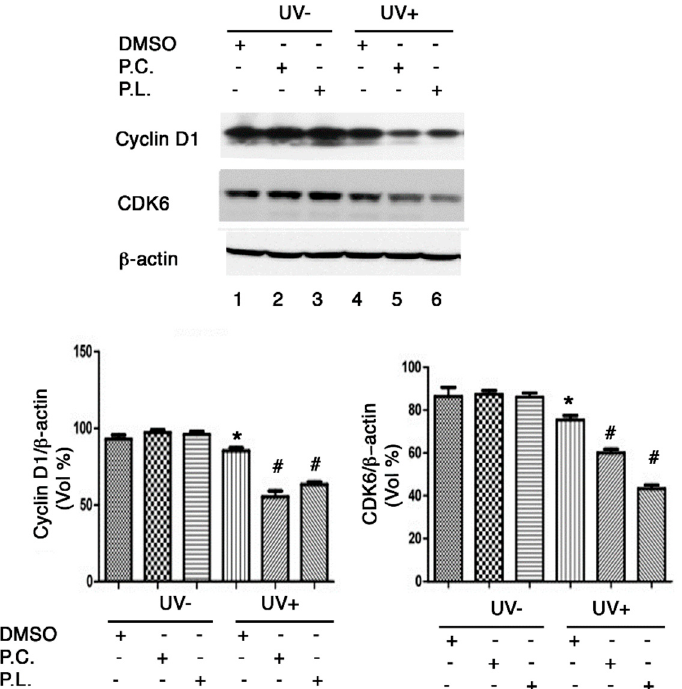
Figure 6. Western blot analysis of G1/S cell cycle regulatory protein expressions in HaCaT cells treated with Perilla leaf or callus extracts. Effects of Perilla leaf and callus extracts on the UVB-induced protein levels of Cyclin D1 and CDK6 in HaCaT cells. Cells were treated with Perilla leaf, callus extracts (0.1 µ g/mL), or DMSO (negative control) overnight, washed with PBS, irradiated with UVB (30 mJ/cm 2 ), and harvested 3 h later. Pellets were subjected to Western blotting using β -actin as a loading control. (Top panel) Representative Western blot for cyclin D1 and CDK6 proteins in HaCaT cells treated with Perilla leaf or callus extracts at 0.1 µ g/mL (D: DMSO treatment; P.C; Perilla callus; P.L: Perilla leaf). (Bottom panel) Proteins were analyzed using the Fusion image system (Fuji, Japan). Data are representative of three independent experiments and expressed as means ± SDs. * p < 0.05; significant versus UVB non-treated controls. # p < 0.05; significant versus UVB treated controls.